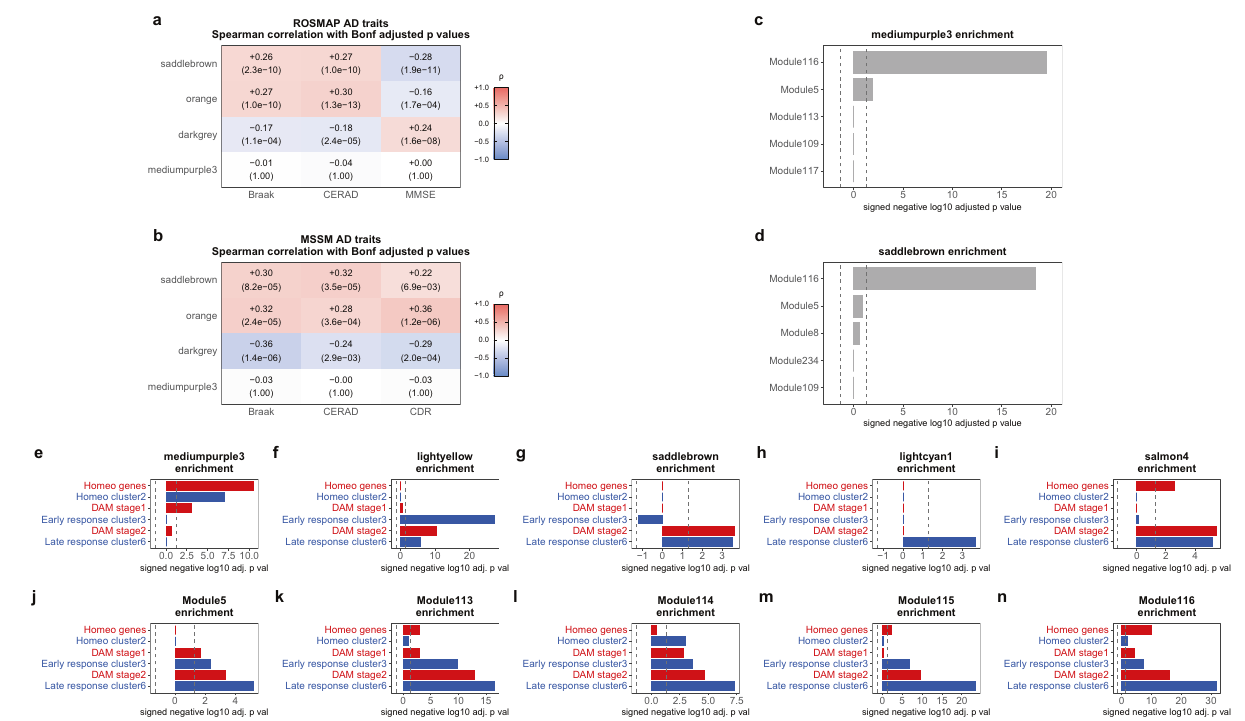
Fig. 5 The modules identi fi ed in our NPH data also correlate with AD pathology in autopsy cohorts. a Saddlebrown , orange , and darkgrey correlate with CERAD score, Braak stage, and MMSE score in 596 RNA-seq pro fi les from the Religious Orders Study and Memory and Aging Project (ROSMAP) Study (representing a range of AD pathologic states) 1 . b Similarly, these modules correlate with CERAD, Braak, and CDR score in RNA-seq pro fi les from frontal cortex in 183 RNA-seq pro fi les from the MSSM dataset 4 (all correlations in a , b are Spearman ’ s correlations with two-sided signi fi cance). c , d Saddlebrown and mediumpurple3 are both primarily enriched for genes from the same microglial module from Mostafavi et al. 1 , suggesting that microglial genes in our data are correlating differently than in autopsy cohorts (see Supplementary Data 9 for enrichment analysis with two-sided Fisher ’ s exact test p values of saddlebrown , orange , darkgrey , and mediumpurple3 with all modules from Mostafavi et al. 1 ). e – n The distribution of enrichment for mouse microglial gene lists from Keren-Shaul et al. 37 (red bars) and Mathys et al. 38 (blue bars) is more segregated in the top fi ve microglial modules from the NPH data ( e – i ) than in the top fi ve microglial modules from Mostafavi et al. 1,39 ( j – n ) (see text for details and discussion and Supplementary Data 8 – 10 for all Spearman ’ s correlations and two-sided Fisher ’ s exact test enrichment p values from these panels). For a , b , each row is separately Bonferroni adjusted, with adjusted p values in parentheses below Spearman ’ s correlations; for two-sided Fisher ’ s exact test in c – n , each panel is separately Bonferroni adjusted — dotted line in c – n is p value =